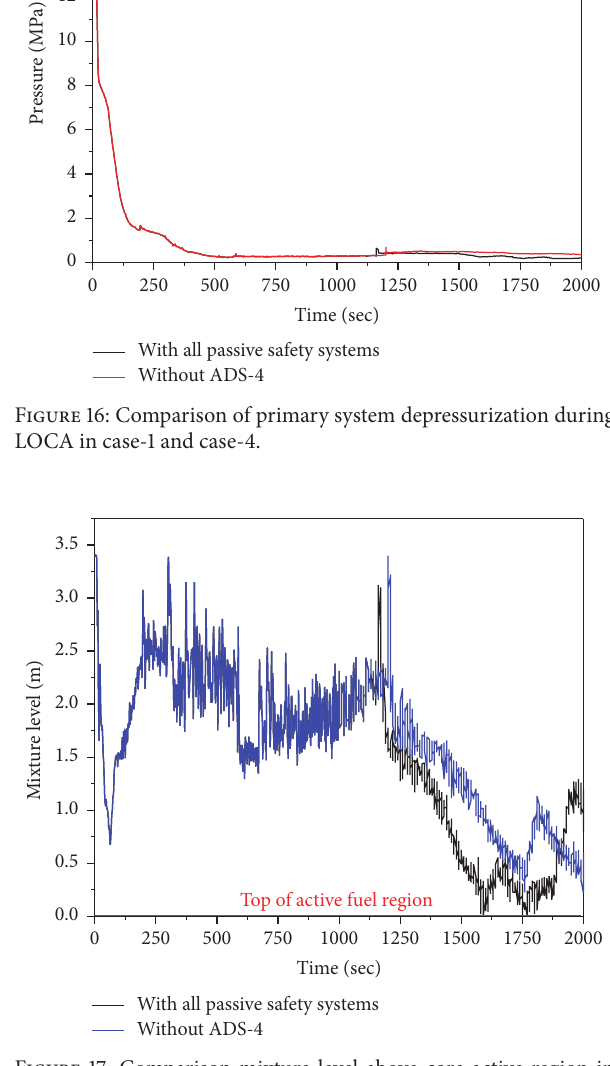
Figure 15: Comparison of cladding inner wall temperature.